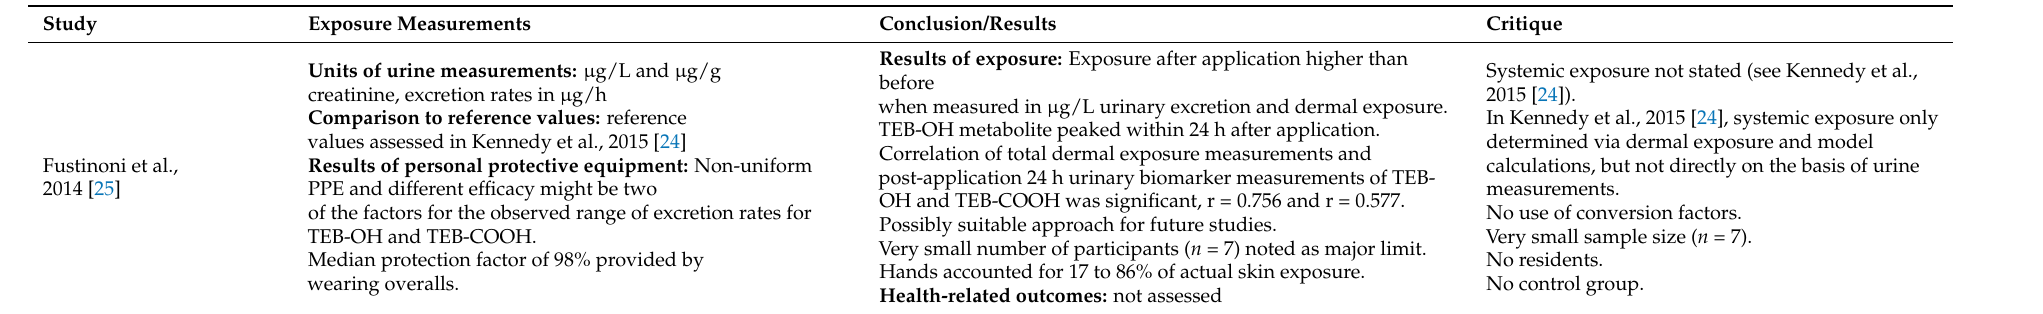
Table 4. Results of studies on vine as the target